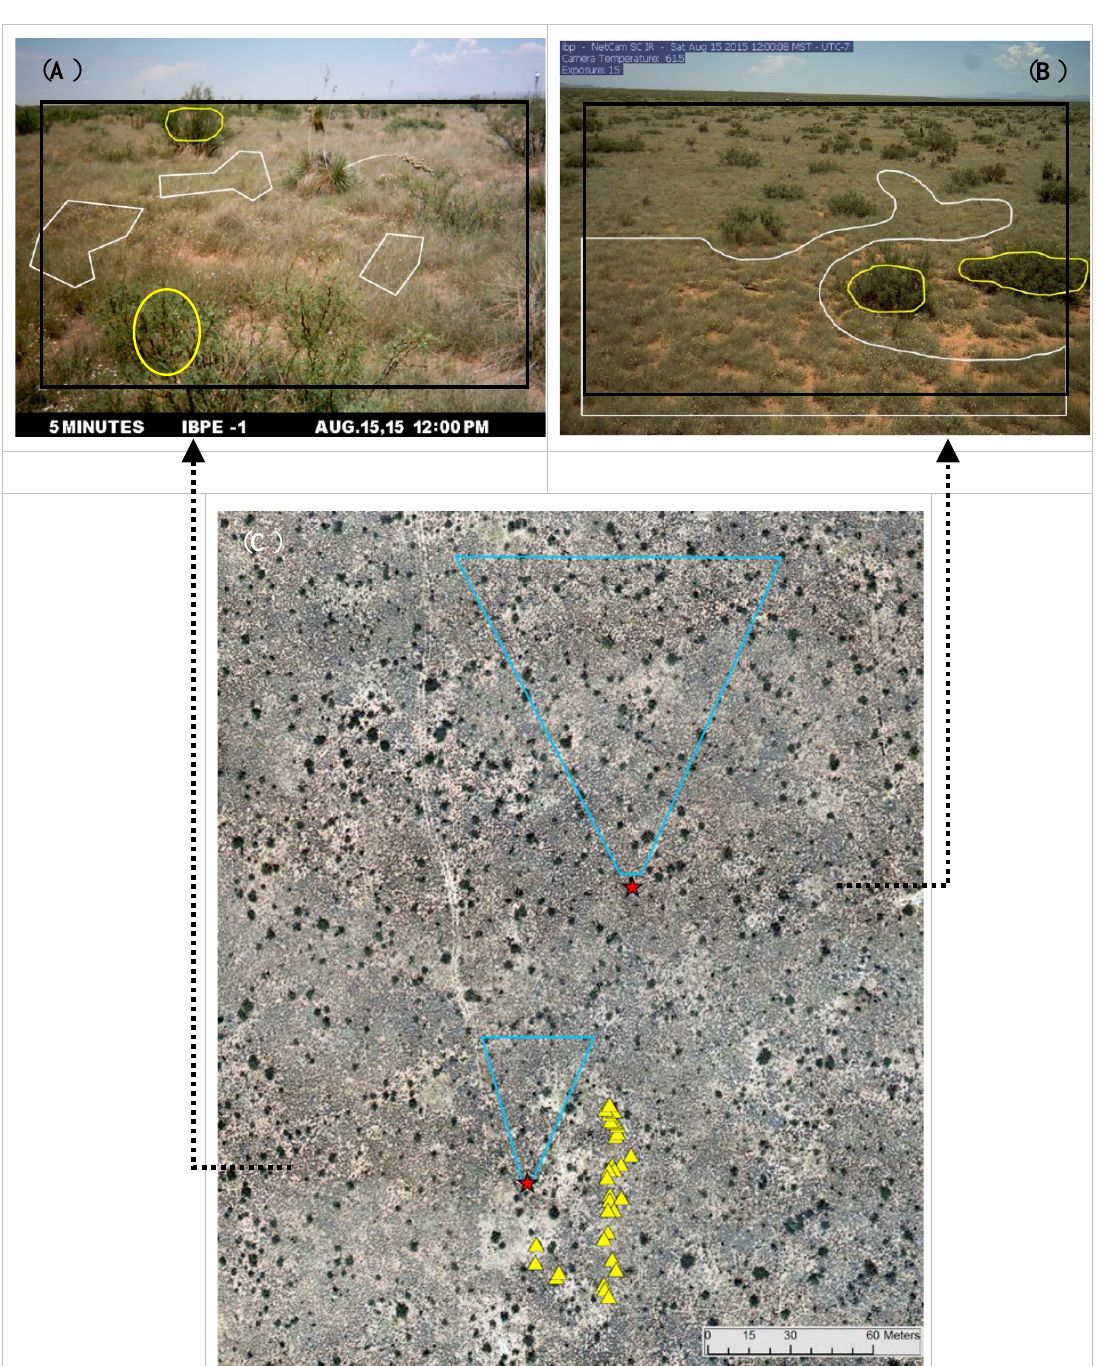
Figure 2. Fields of view for: Plantcam ( A ); and Netcam ( B ). Polygon outlines represent regions of interest (ROIs): black grama (white), mesquite (yellow) and landscape (black). Configuration of two cameras (red stars) relative to focal plants (yellow triangles) and the approximated areal extent of camera fields of view area are depicted as blue polygons ( C ). The underlying image was acquired from an unmanned aerial system on 23 October 2013.